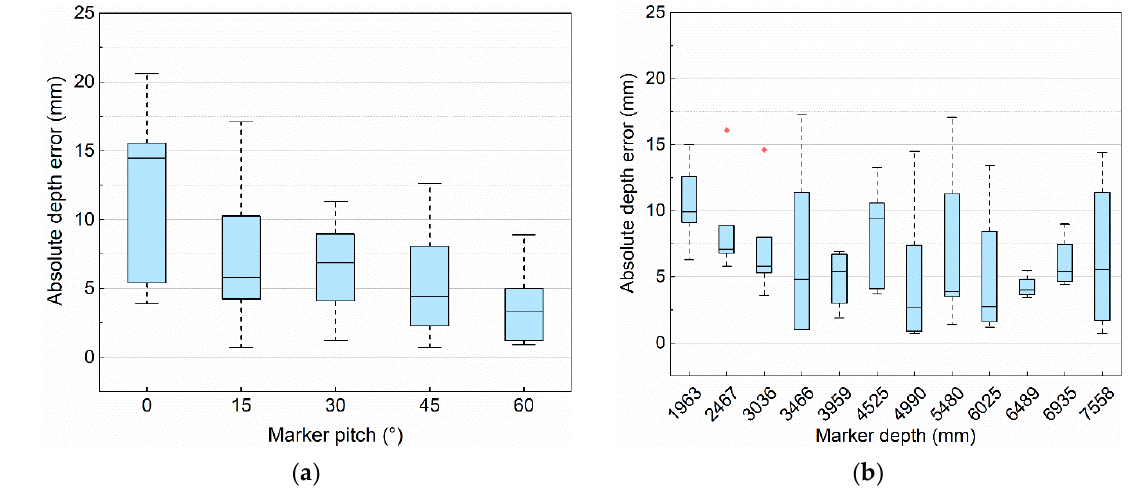
Figure 10. The absolute depth error with different configurations. ( a ) Absolute depth error under different marker pitches. ( b ) Absolute depth error under different marker depths.